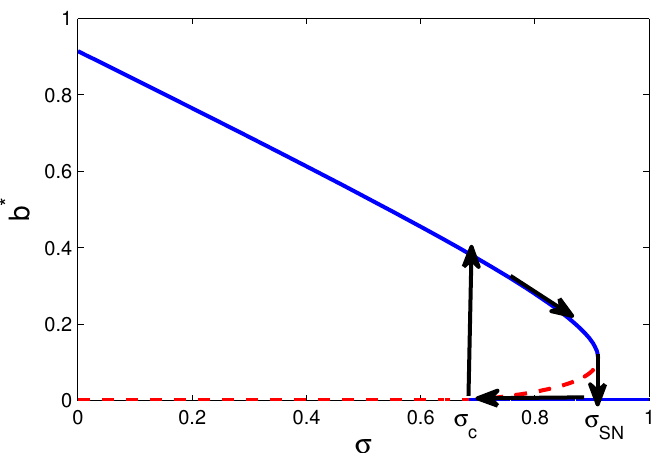
Figure 2. Graphical representation of an hysteresis cycle on the bifurcation diagram in the plane ( σ , b ∗ ) in the case α > α ∗ , where a backward scenario is obtained. The other parameters are as in Figure 1 (right). Here α ∗ = 1.1684, σ c = 0.6850 and the value σ SN = 0.9105 is the saddle-node bifurcation threshold. The solid lines (-) denote stability; the dashed lines (- -) denote